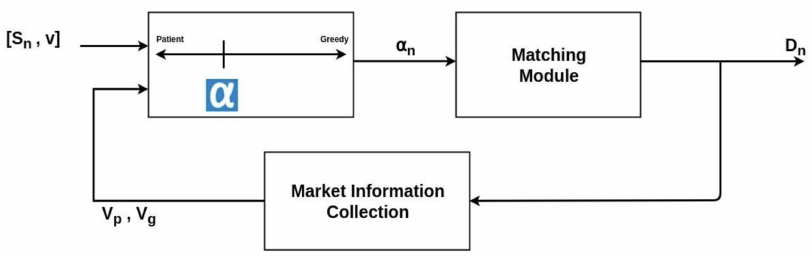
Figure 11. The block diagram of the proposed DTS-based matching